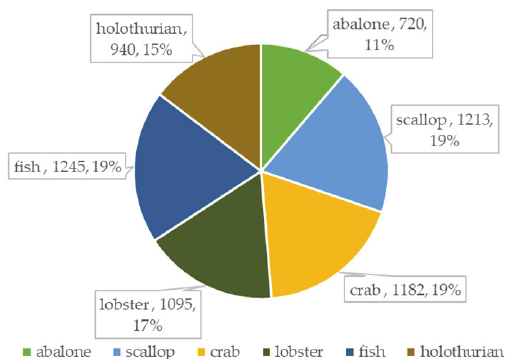
Figure 11. The number and proportion of each species.